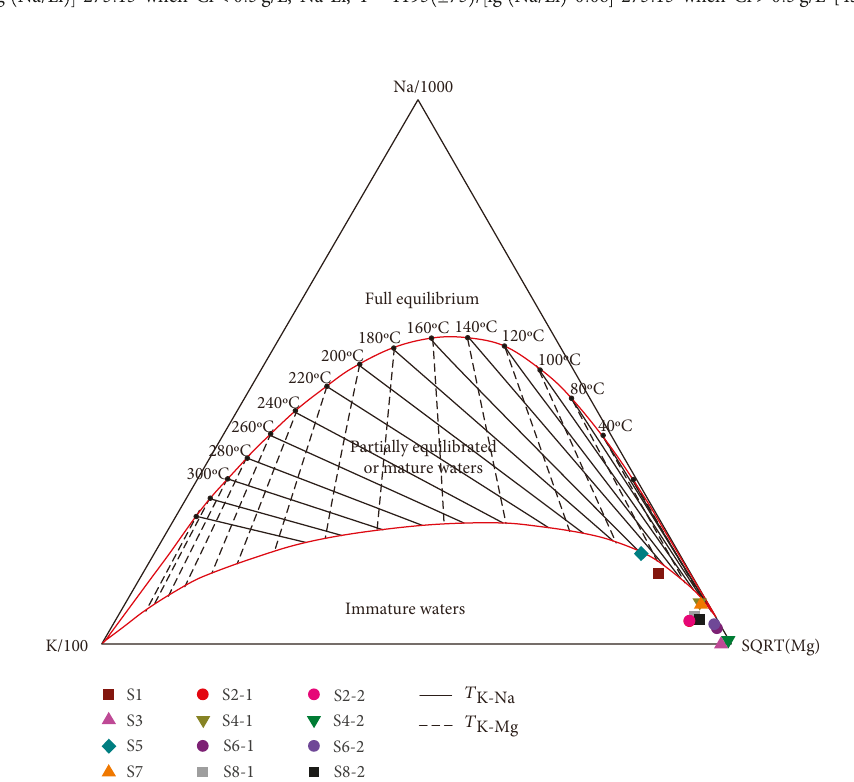
is a set of isotherm according to the K ‐ Na